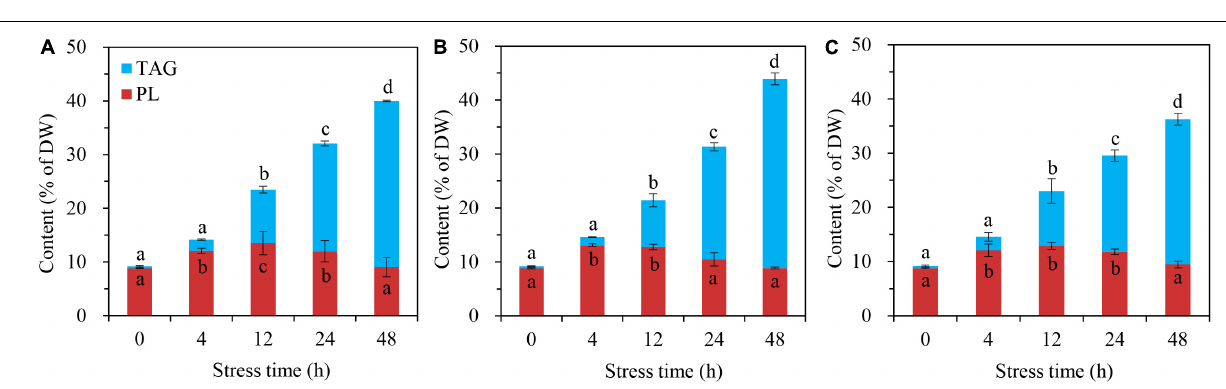
1 > autotrophic ( Figure 5A ). The TAG amount in BAFJ5 cells